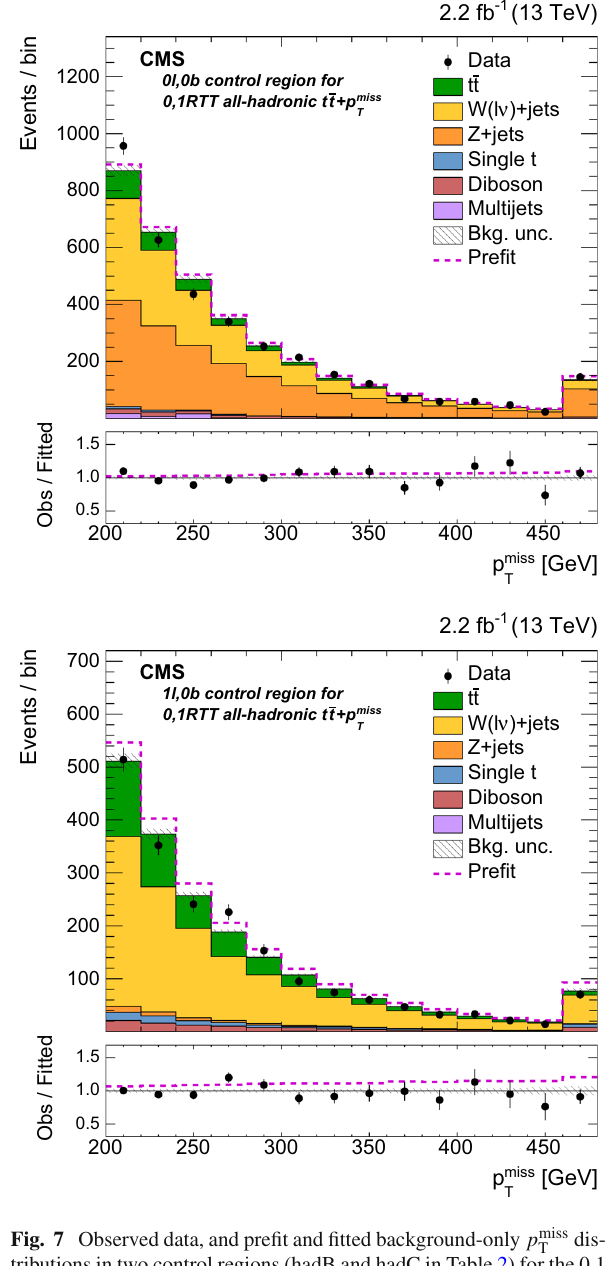
Fig. 7 Observed data, and prefit and fitted background-only p miss dis- T tributions in two control regions (hadB and hadC in Table 2) for the 0,1 RTT hadronic tt + p miss signal region with 0 leptons (upper) and with T 1 lepton (lower) and 0 b tags. The 0 lepton control region is used to constrain W + jets and Z + jets backgrounds. The 1 lepton CR provides an additional constraint on W + jets background. The last bin contains overflow events. The lower panels show the ratios of observed data to fitted background yields. In both panels, the statistical uncertainties of the data are indicated as vertical error bars and the fit uncertainties are indicated as hatched bands. Prefit yields and the ratios of prefit to fitted background expectations are shown as dashed magenta histograms